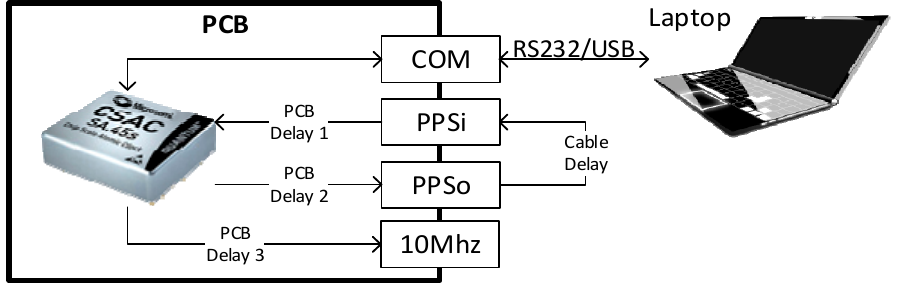
Figure 4. Basic CSAC configuration, measuring delays test configuration.